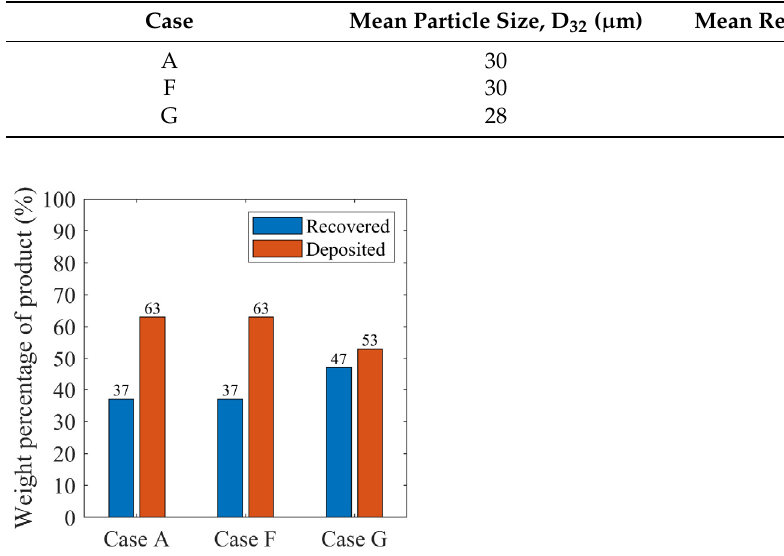
Figure 15. Product recovery at outlet and deposition in the dryer for cases A, F, and